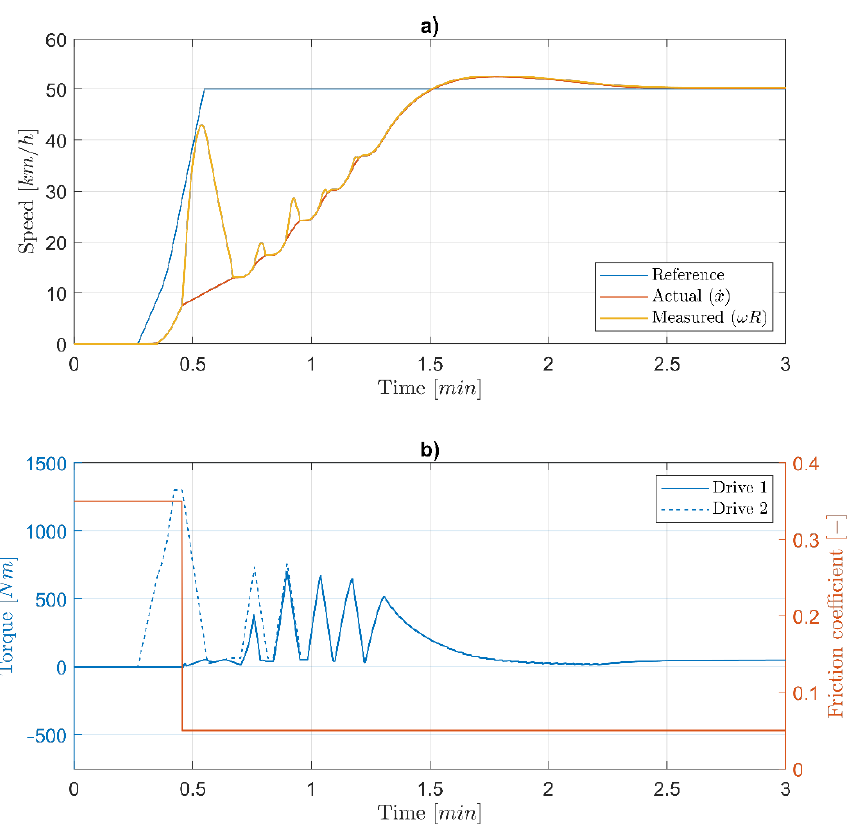
Figure 15. Simulation results of the last scenario in terms of the speed of the vehicle ( a ) and the motor drive torque ( b ). In addition, the variation of the friction coefficient is reported.